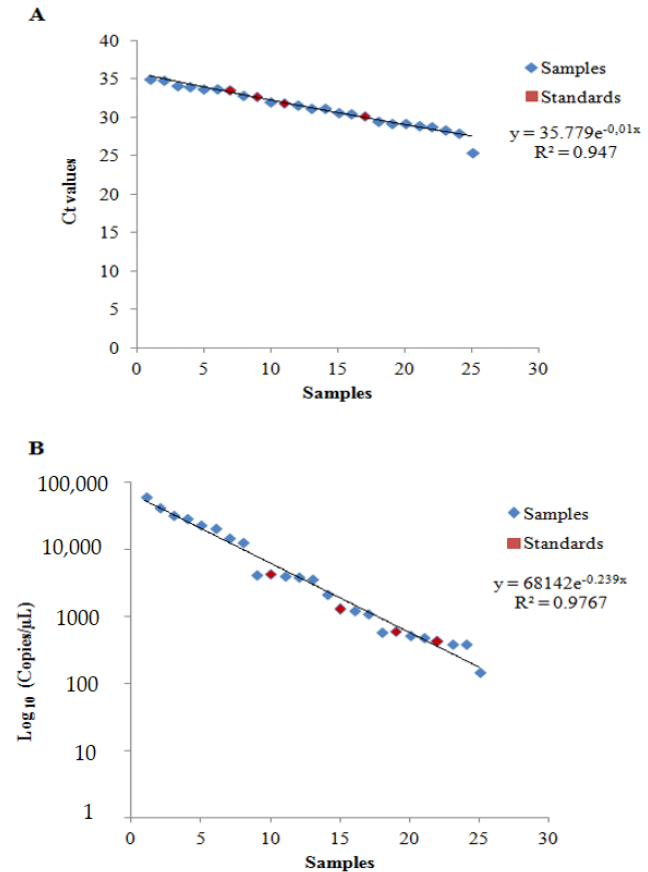
Figure 3. Scatter plot of ( A ) qPCR and ( B ) ddPCR analyses.